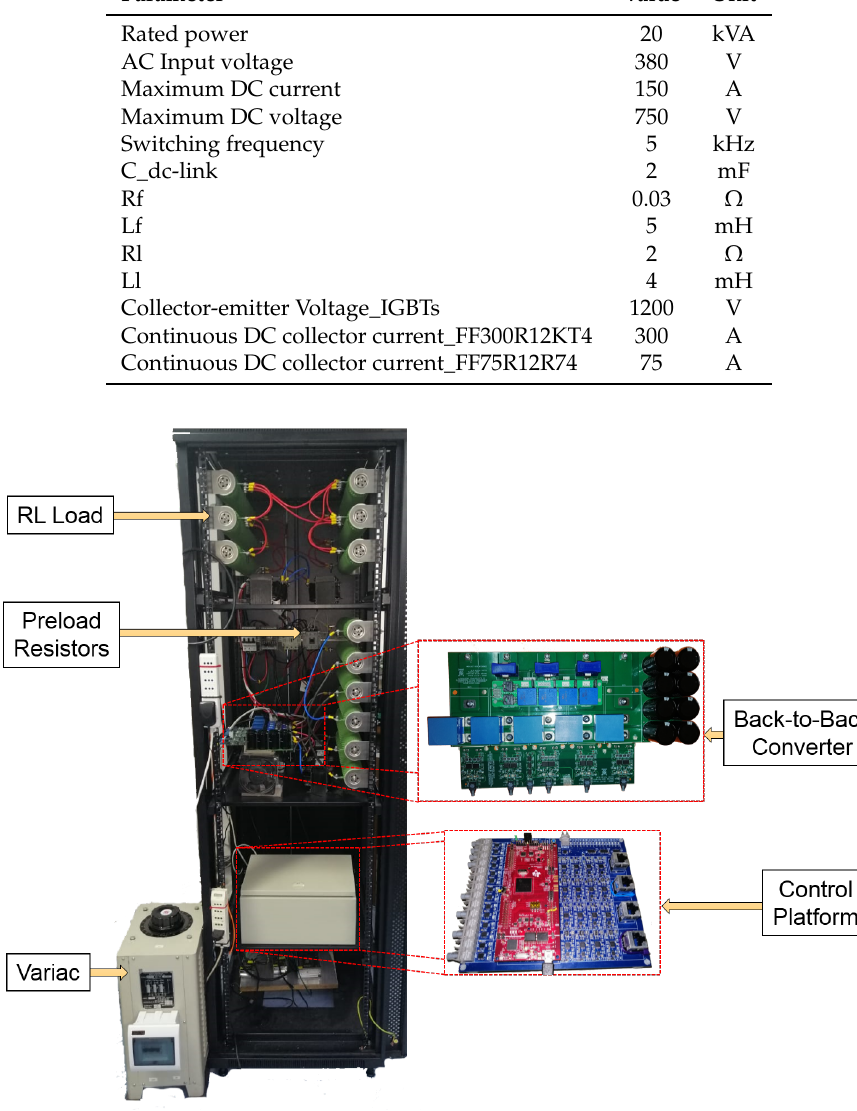
Figure 9. Experimental system